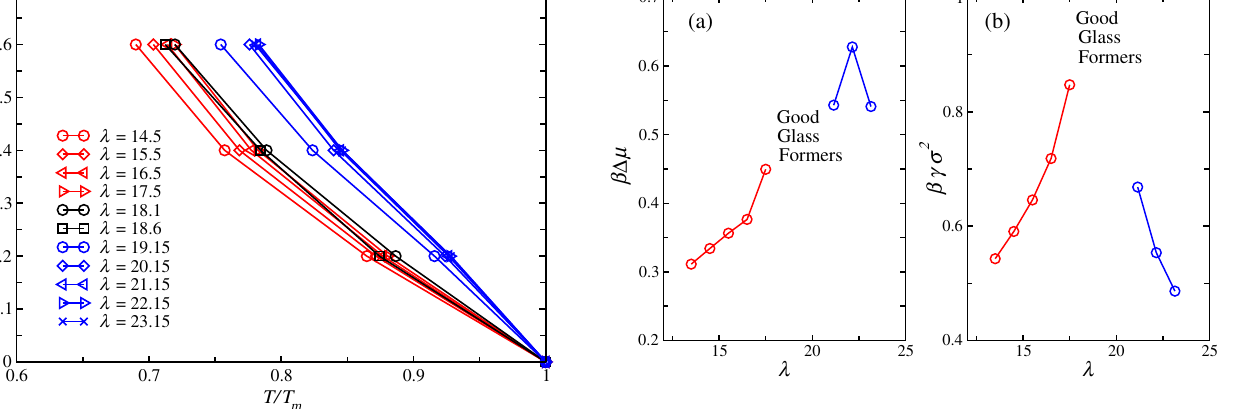
FIG. 5. Thermodynamic driving force as a function of T=T the SW model. The different lines represent different values of λ in the bcc (red lines), β -tin (black lines), and dc (blue lines) stable regions.